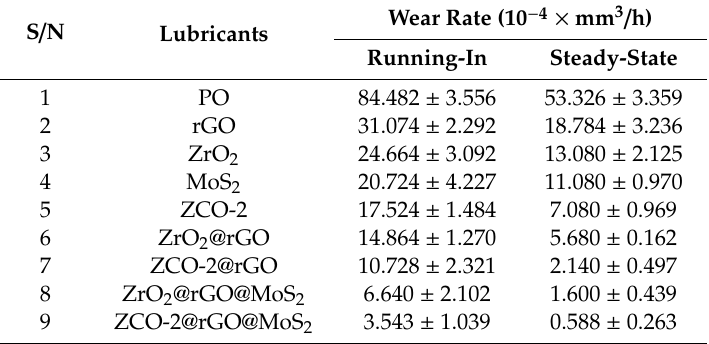
Figure 7. Variation of mean wear volume with sliding time for para ffi n oil without (given in inset) and with 0.125% w / v of di ff erent nano additives for 1.5 h test duration. Table 1. Wear-rate for para ffi n oil (PO) in the presence and absence of nano additives for 60 min test duration at 392 N applied